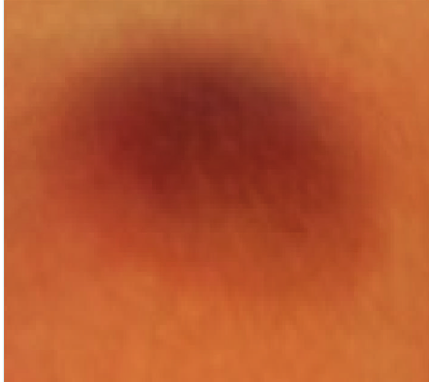
Figure 1: Initial presentation of the 5 cm nodule found on the right posterior shoulder.